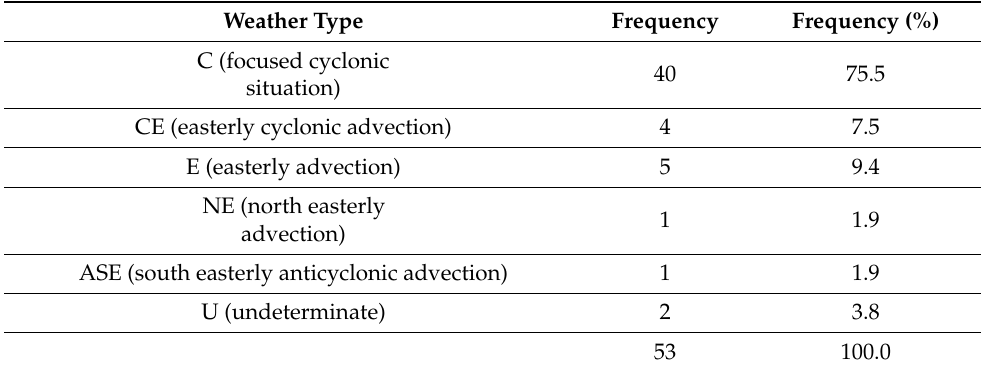
Table 2. Absolute and relative frequency of weather types according to Jenkinson and Collison’s method applied to days with rainfall equal to or above 200 mm in the Balearic